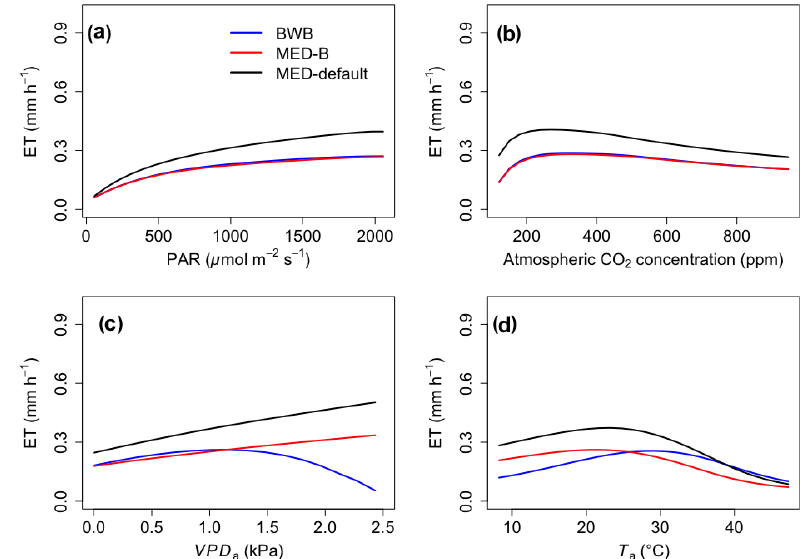
Figure 3. The responses of evapotranspiration (ET) to scenarios with (a) radiation, (b) CO 2 , (c) VPD a , and (d) T a for the three model setups: BWB (blue), MED-B (red), and MED-default (black).